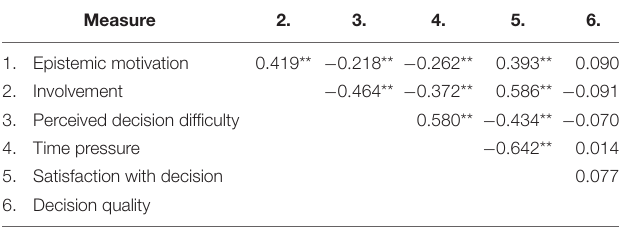
TABLE 6 | Correlation Coefficients. Measure